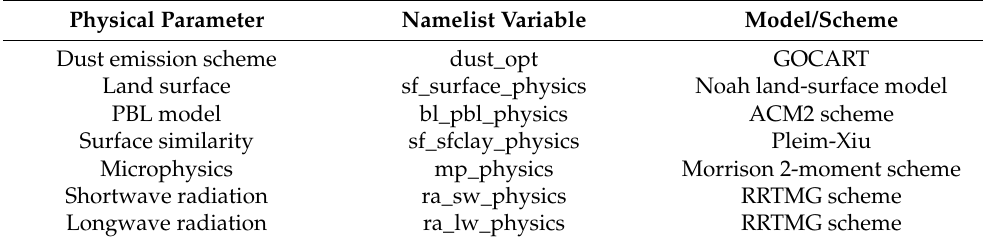
Table 1. Physical parameters and variables utilized in